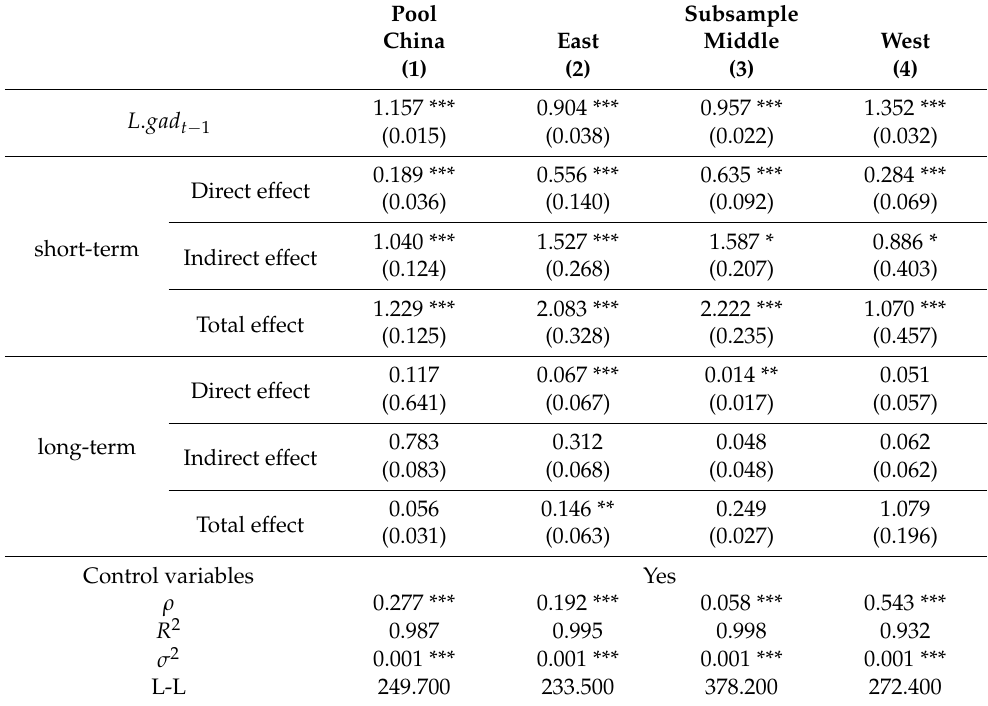
Table 5. The results of the dynamic spatial Durbin